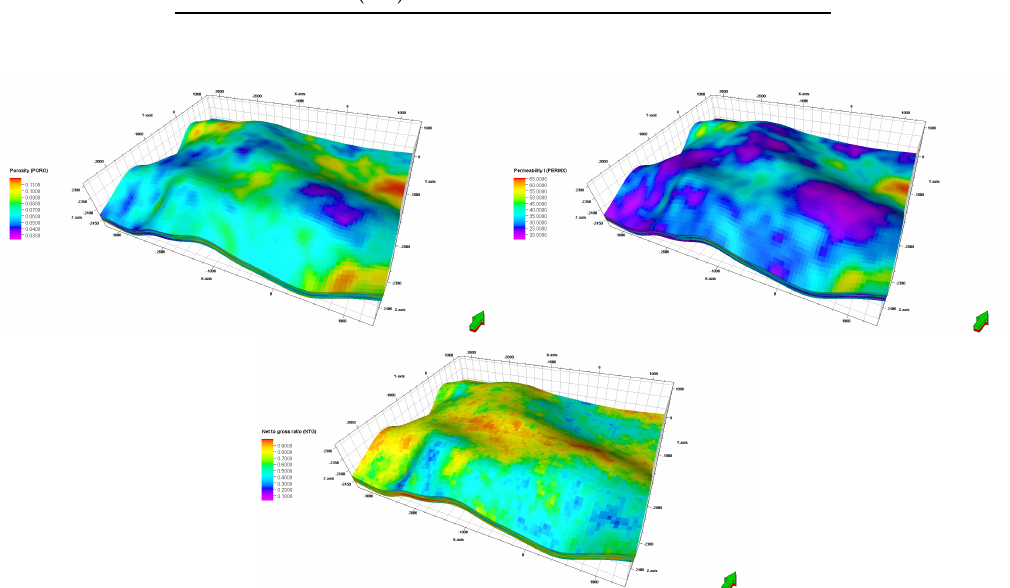
Figure 13. Distributions of the porosity ( left ), permeability ( right ), and net-to-gross ratio (center) in the reservoir model. Source: the synthetic reservoir model was developed by AGH UST Drilling, Oil and Gas Faculty for academic research purpose. The reservoir horizon map, as well as the petrophysical